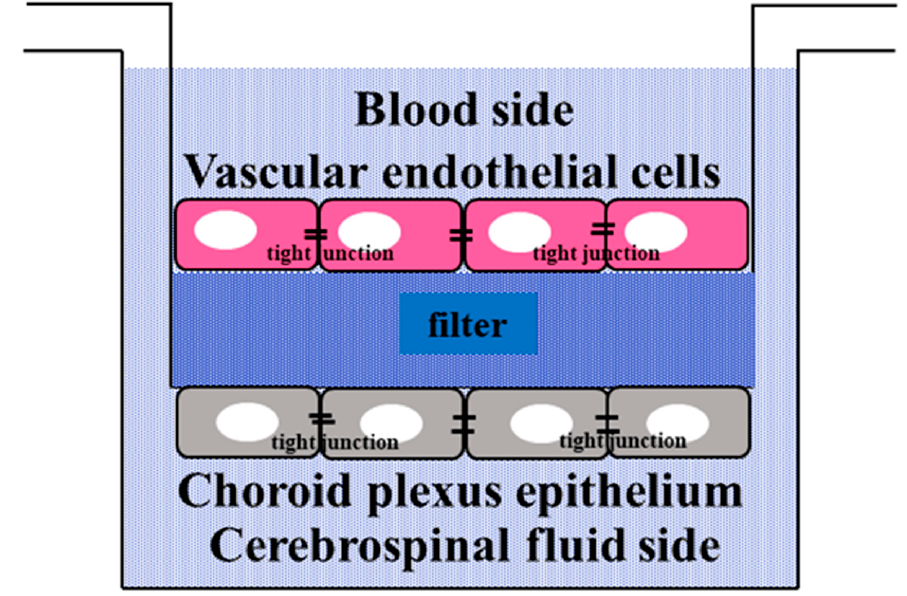
Figure 7. A rough drawing of the BCSFB model.